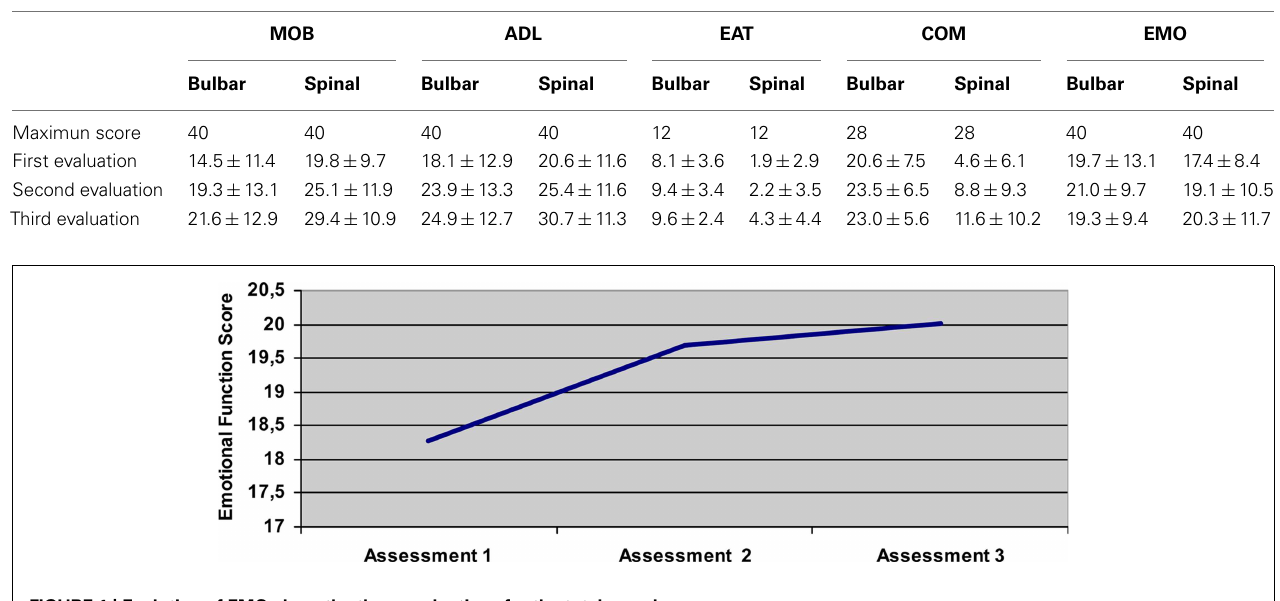
Table 2 | Mean and SD for each area in bulbar and spinal onset.